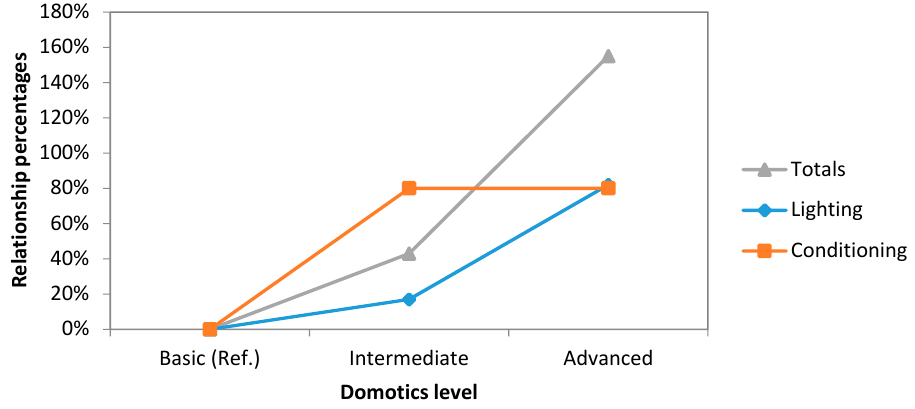
Figure 7. Comparative study graph concerning to economical savings (lighting and conditioning).